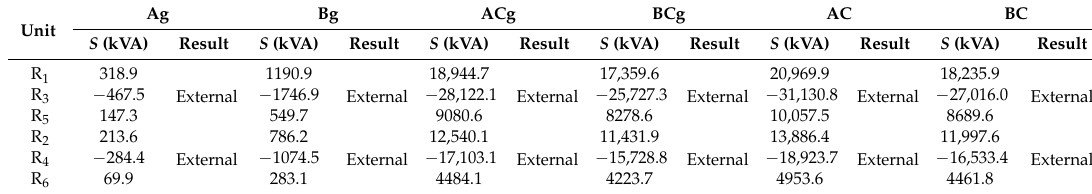
Table 7. Simulation results of the different fault types for the external faults.